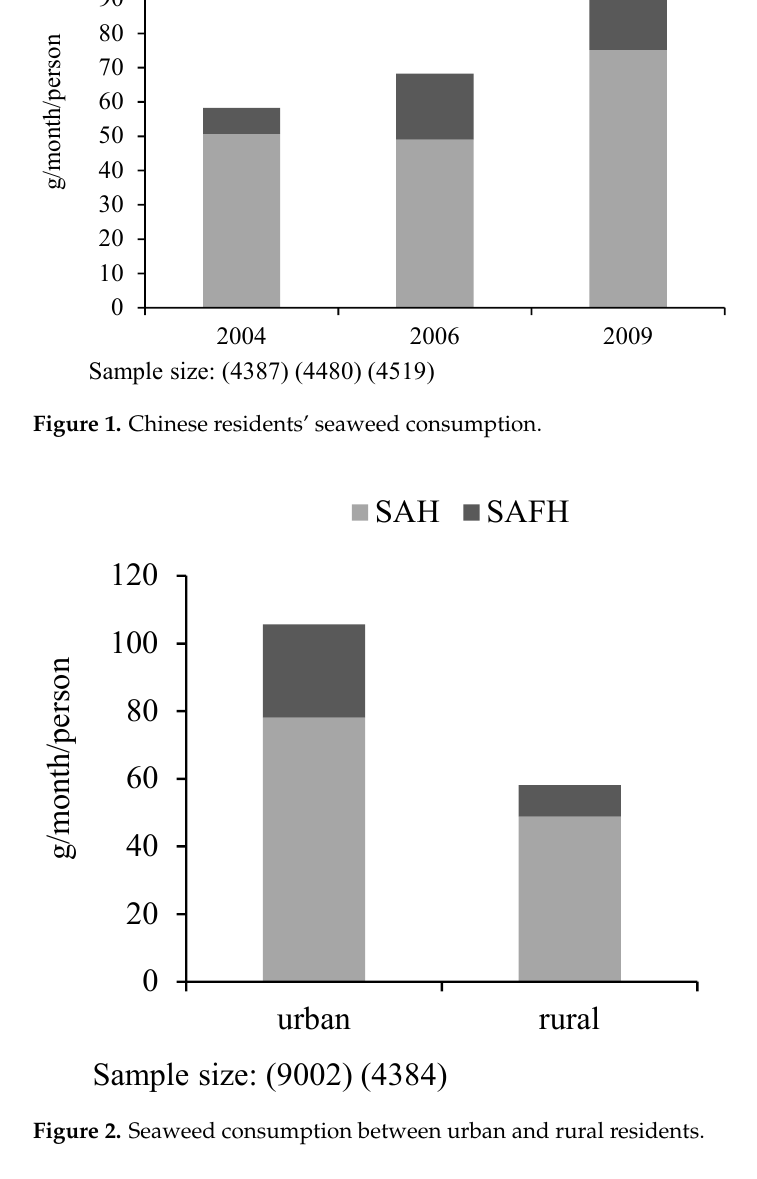
Figure 2. Seaweed consumption between urban and rural residents.